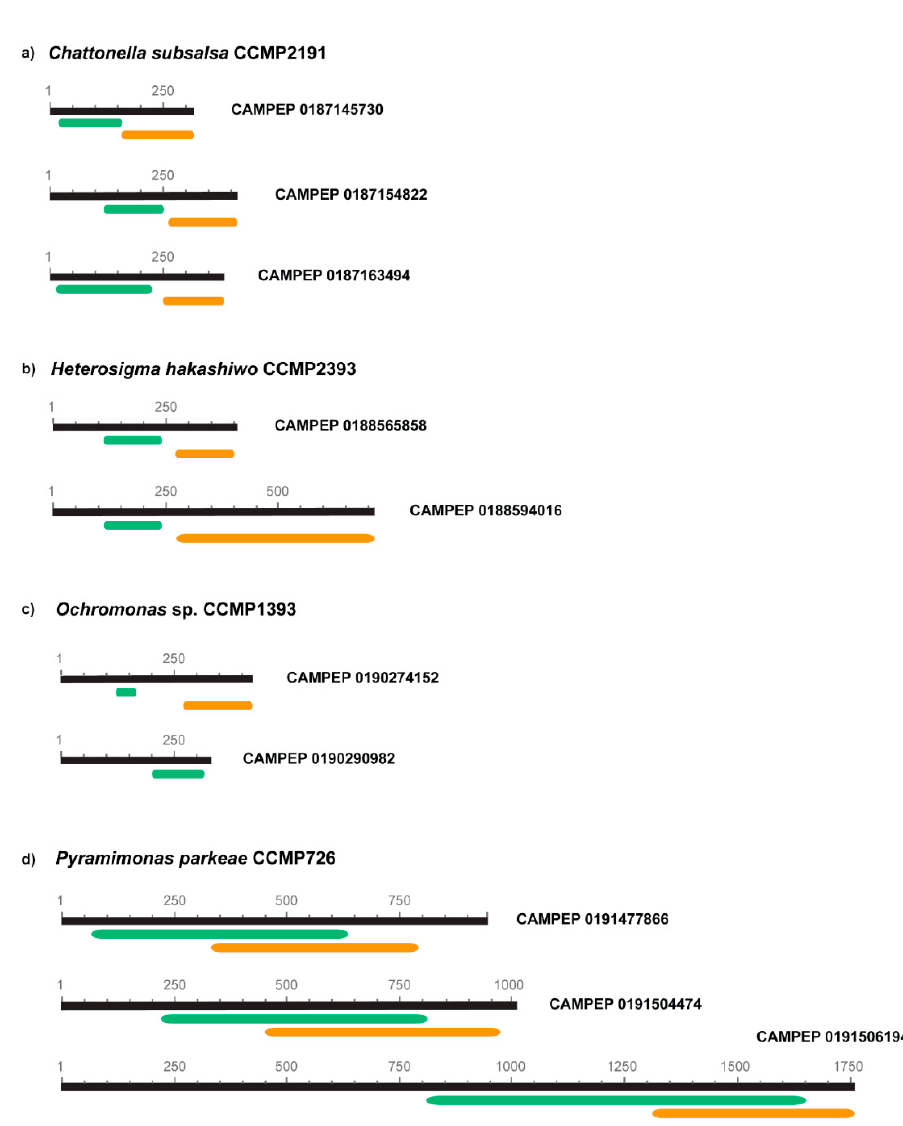
Figure 4. Localisation and annotation of chalcone / stilbene synthase domains in strains containing multiple transcripts: Chattonella subsalsa CCMP2191 ( a ), Heterosigma akashiwo CCMP2393 ( b ), Ochromas sp. CCMP1393 ( c ), and Pyramimonas parkeae CCMP726 ( d ). Green bars refer to N-terminus domains, whereas orange bars to C-terminus ones. Transcript codes (CAMPEP) are as in File